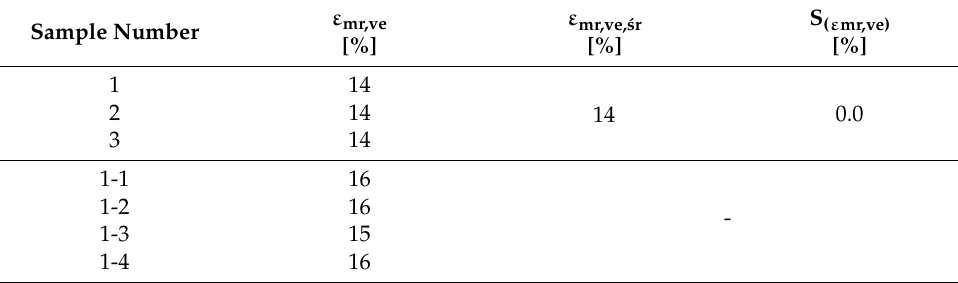
Table 10. Results of determination of strain at compression ε mr,ve .